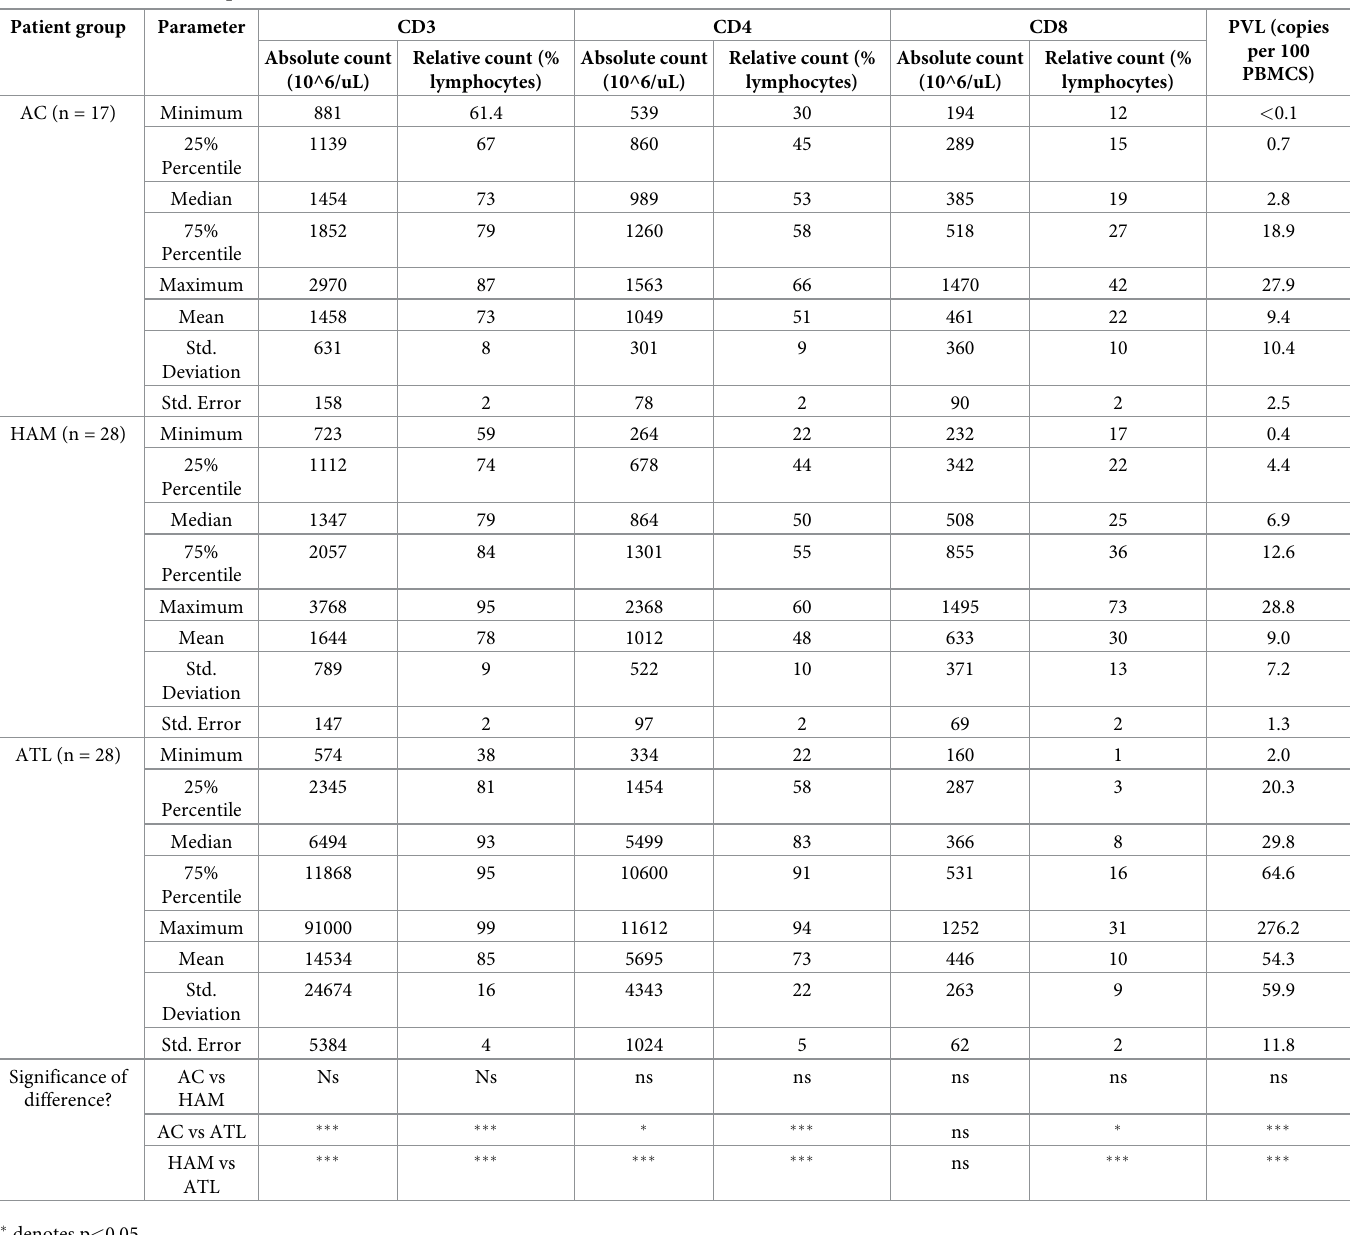
Table 1. T-cell subsets and proviral load in AC, HAM and ATL. Patient